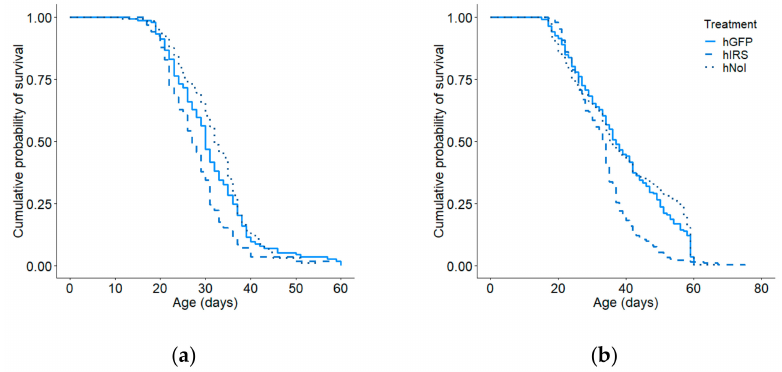
Figure 6. E ff ect of irs knockdown on total lifespan for the high pollen hoarding strain by host colony. In the high strain, irs knockdown (hIRS) resulted in decreased lifespan relative to the GFP control (hGFP) in both colonies ( a ) colony 1: Kaplan–Meier: χ 2 = 14.9, p = 0.0006, n = 411, Cox–Mantel: p = 0.0052, ( b ) colony 2: Kaplan–Meier: χ 2 = 28.3, p < 0.0001, n = 638, Cox–Mantel: p = 0.001. There was no e ff ect of handling on total lifespan in the high strain (Cox–Mantel: hGFP vs. hNoI, colony 1: p = 0.482, colony 2: p =